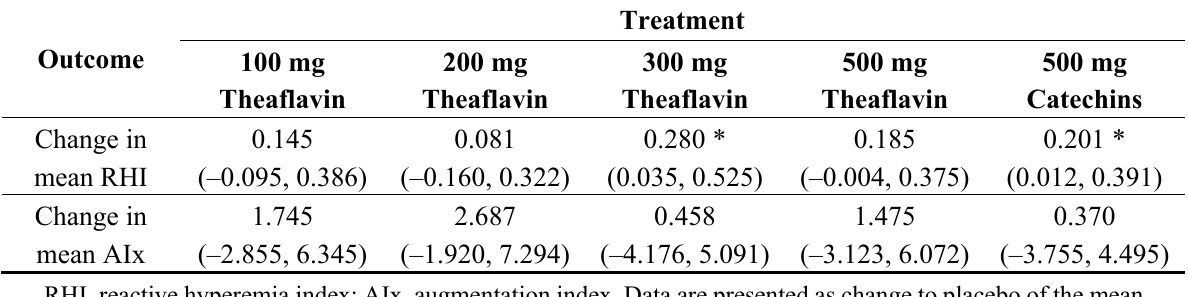
Table 2. Vascular function in healthy subjects after the consumption of a single dose of 100, 200, 300 and 500 mg theaflavins and 500 mg